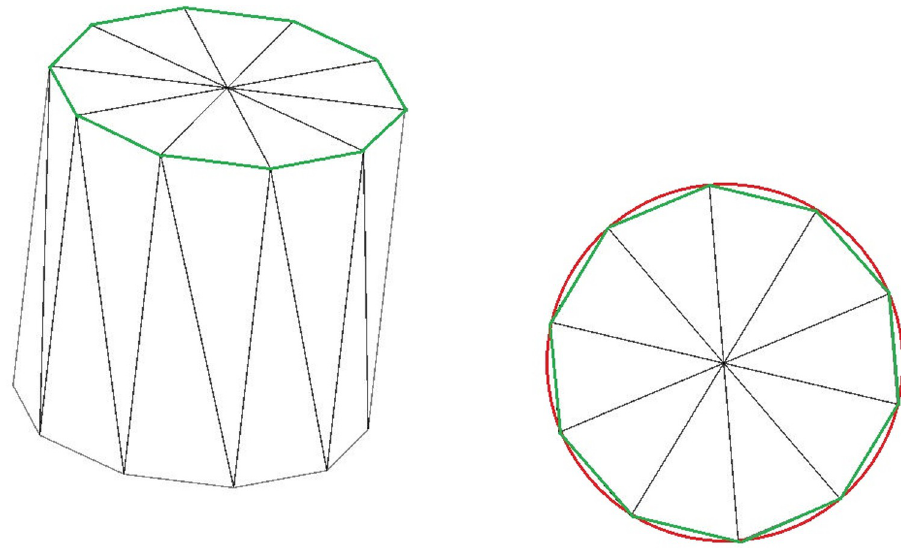
Fig 3. Difference between real (red) and simulated log shape